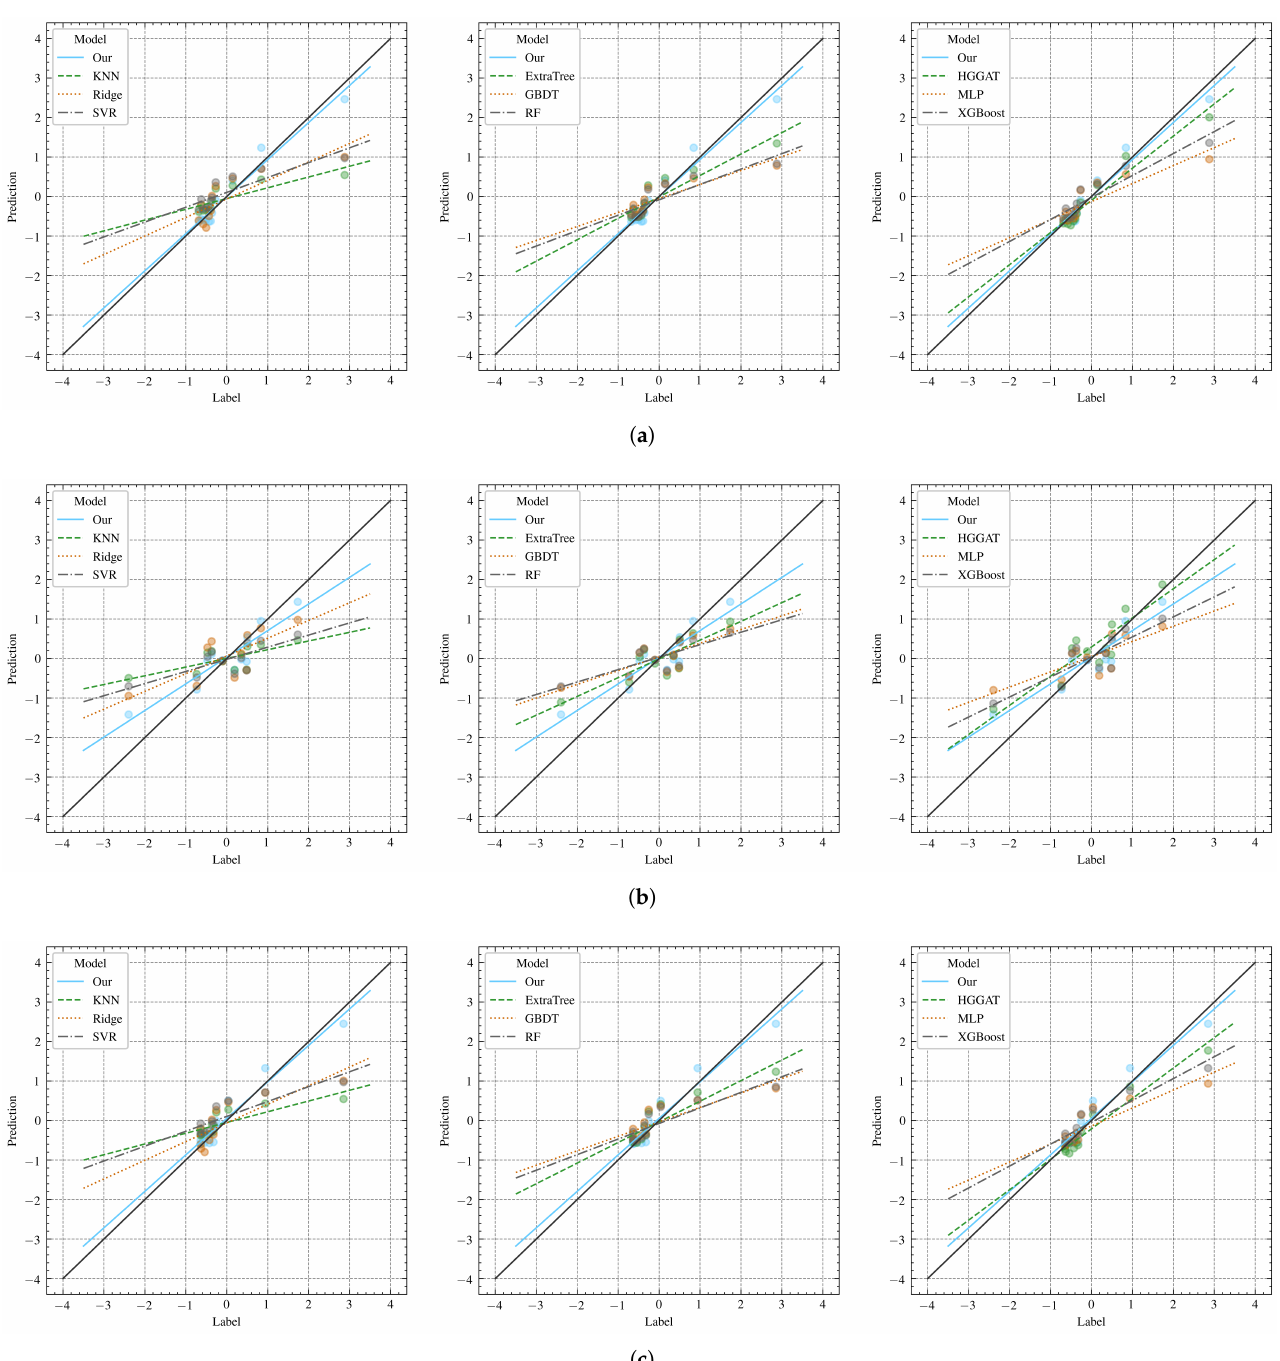
Figure 5. Image structure and graph structure. ( a ) The best fit regression line of the prediction results under the average grain size index. ( b ) The best fit regression line of the prediction results under the twin boundaries density index. ( c ) The best fit regression line of the prediction results under the average surface